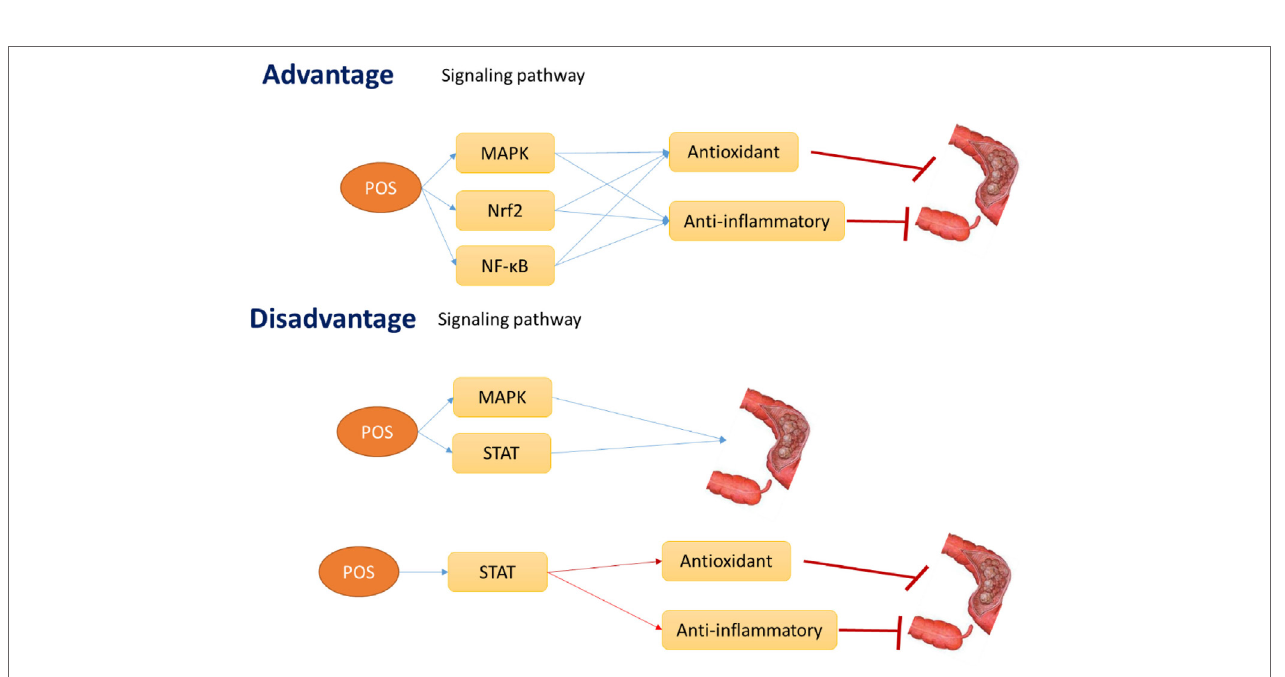
FiguRe 7 | The hypothesis of the advantage and disadvantage effects of pectin oligosaccharides on colon cancer